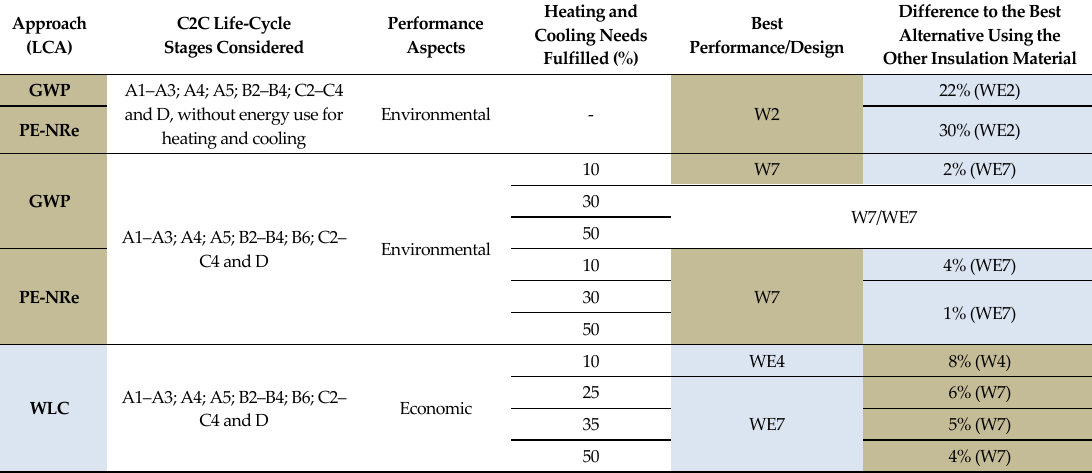
Table 6. Single-leaf external wall solution with the best performance, without considering the reference wall (the colour of each row depends on the best performing solution for each indicator: Brown for ICB and blue for EPS).